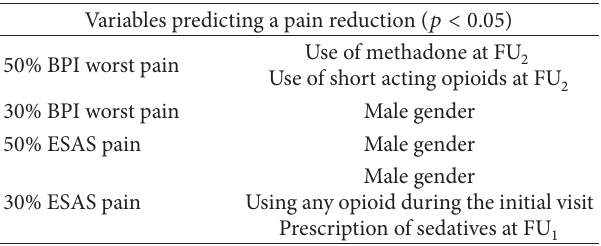
Table 7: Predictors for positive analgesic